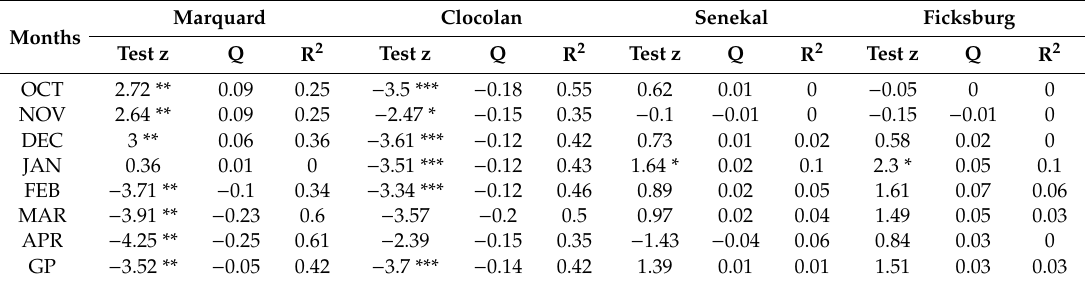
Table 5. Setsoto monthly growing period minimum temperature annual trends during the growing period from 1985–2016. Mann Kendall (MK) trend (Test Z) and Sen’s slope estimate (Q). Marquard Clocolan Senekal Ficksburg Months Test z Q R 2 Test z R